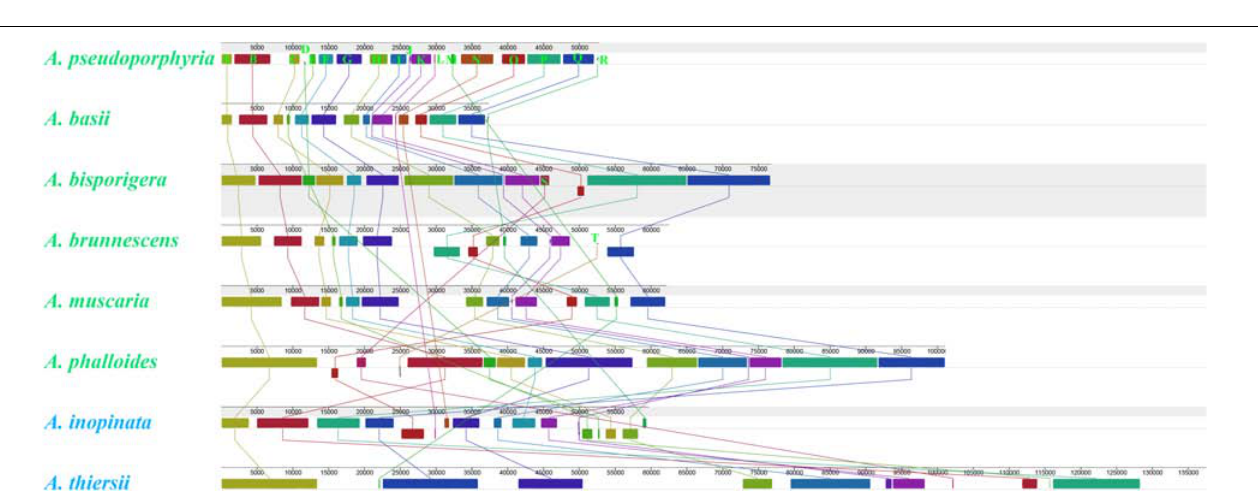
FIGURE 4 | Colinearity analysis of eight Amanita mitogenomes using Mauve. Twenty homologous regions were detected among the eight mitogenomes. The sizes and relative positions of the homologous regions varied among mitogenomes. The Amanita species with blue fonts are asymbiotic, while the species with green fonts are